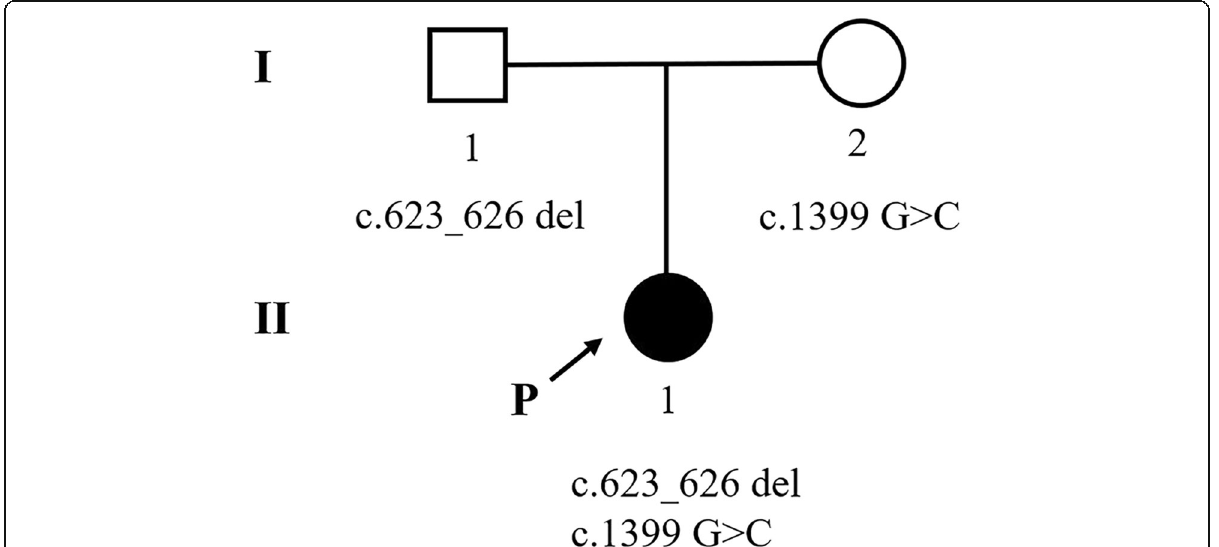
Fig. 1 ETFDH gene mutations determined by NGS in infant patient and her family. (The filled black symbols represent the affected members and the arrow denotes the proband)